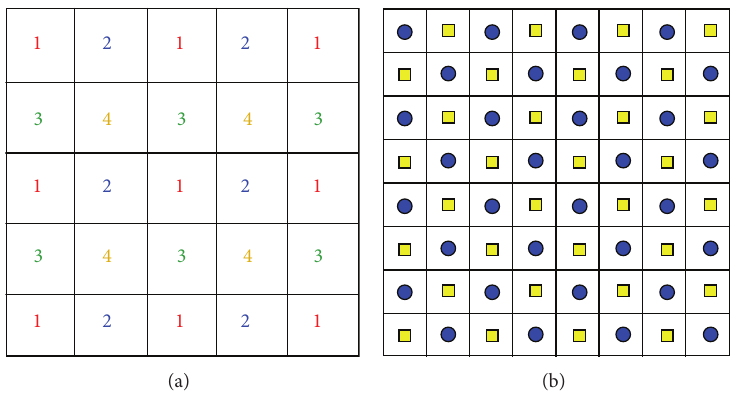
Figure 2: Multiple descriptions (a) using polyphase downsampling and (b) using quincunx downsampling.